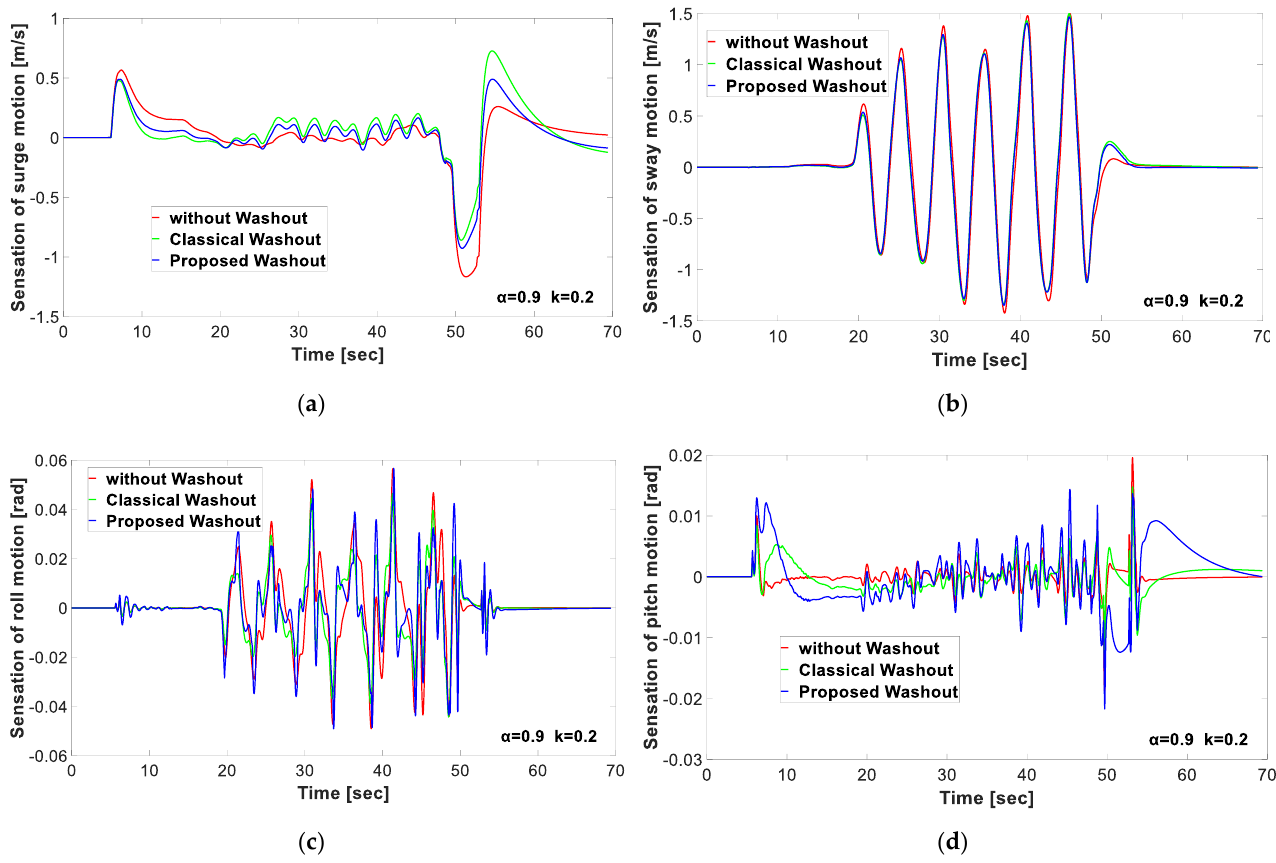
Figure 17. Motion sensation in the case of slalom driving. ( a ) Motion sensation of surge direction. ( b ) Motion sensation of sway direction. ( c ) Motion sensation of surge direction. ( d ) Motion sensation of sway direction.